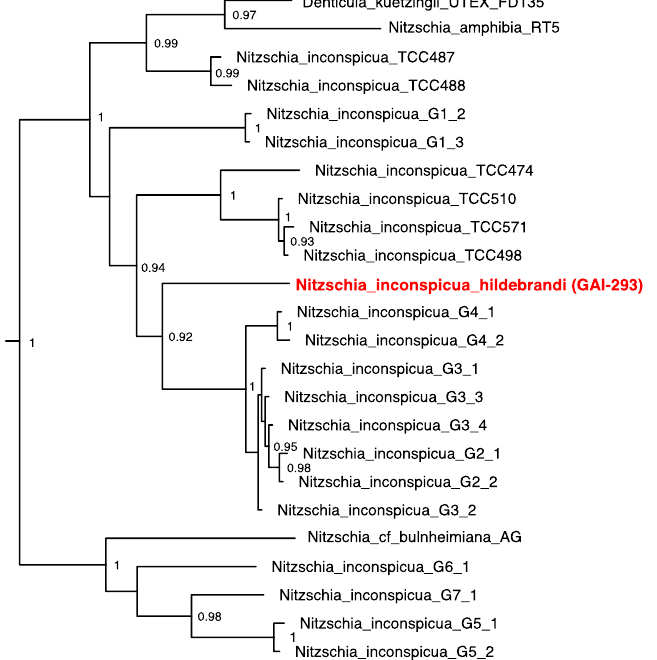
Figure 2. Concatenated multilocus gene tree of Nitzschia inconspicua strains. Alignments were constructed from 18S (SSU) and 23S (LSU) nuclear rRNA genes combined with chloroplast genes psbC (photosystem II reaction center protein C), and rbcL (ribulose bisphosphate carboxylase large chain). Supplementary Figure S1 shows a more complete version of this tree including the entire Bacillariaceae family. Accession numbers for concatentated genes are provided in Supplementary Table S5.